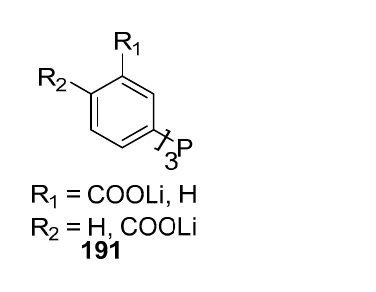
Figure 30. (tris(m ‐ carboxyphenyl) phosphine trilithium salt (m ‐ TPPTC)) and (p ‐ TPPTC) (TPPTC: tris(m ‐ carboxyphenyl) phosphine trilithium salt).